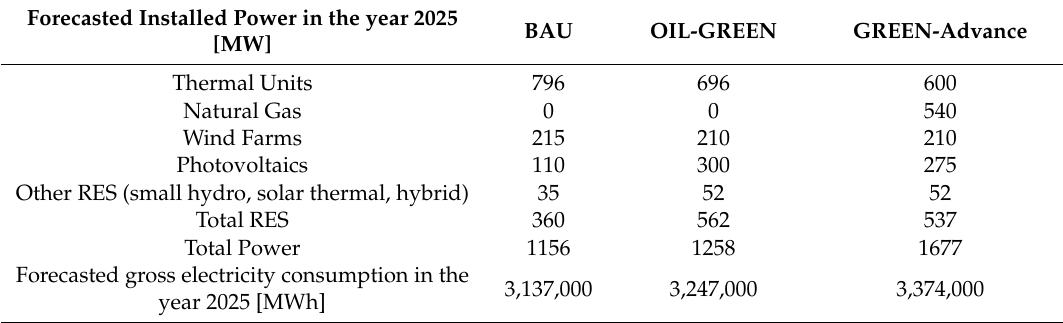
Table 1. The forecasted installed power of all kind of energy units in the Crete power grid in the year 2025 for the three